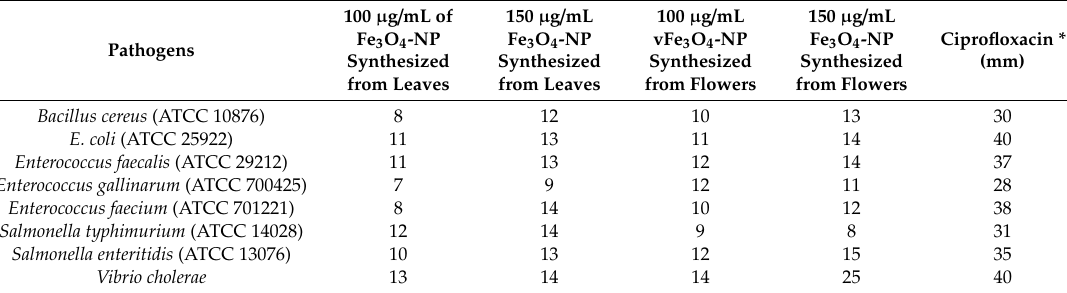
Table 1. Antimicrobial activity of Fe 3 O 4 -NP on selected